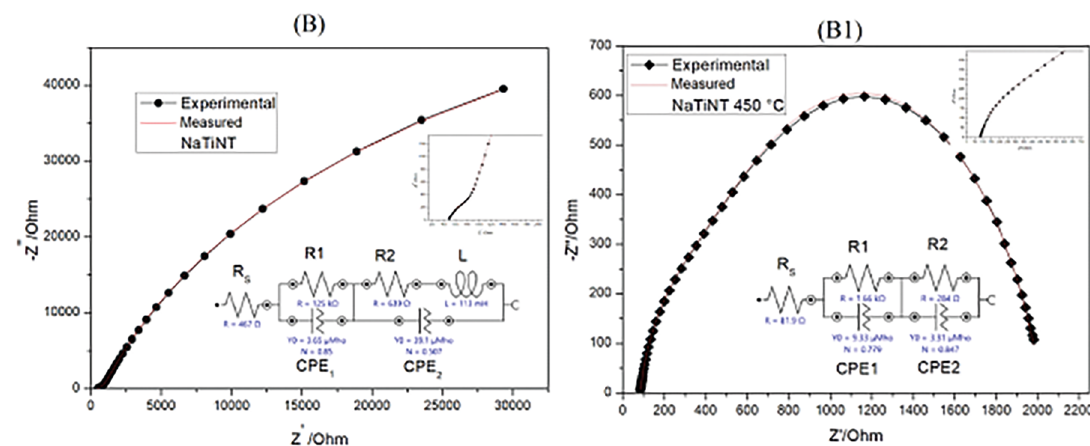
Figure 6. Nyquist diagrams of the cells with (B) NaTiNT and (B1) NaTiNT-450 °C.